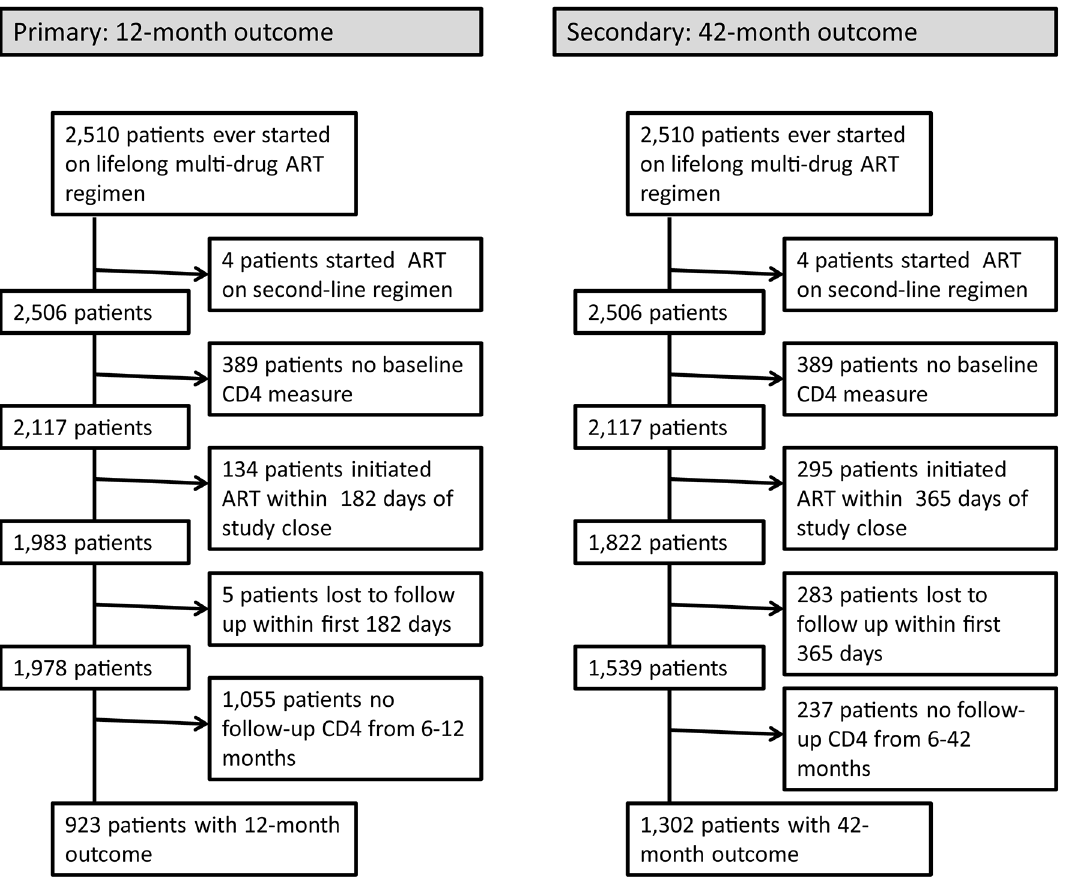
Figure 1. Flow Chart for Participants in the 12-Month and 42-Month Analyses.